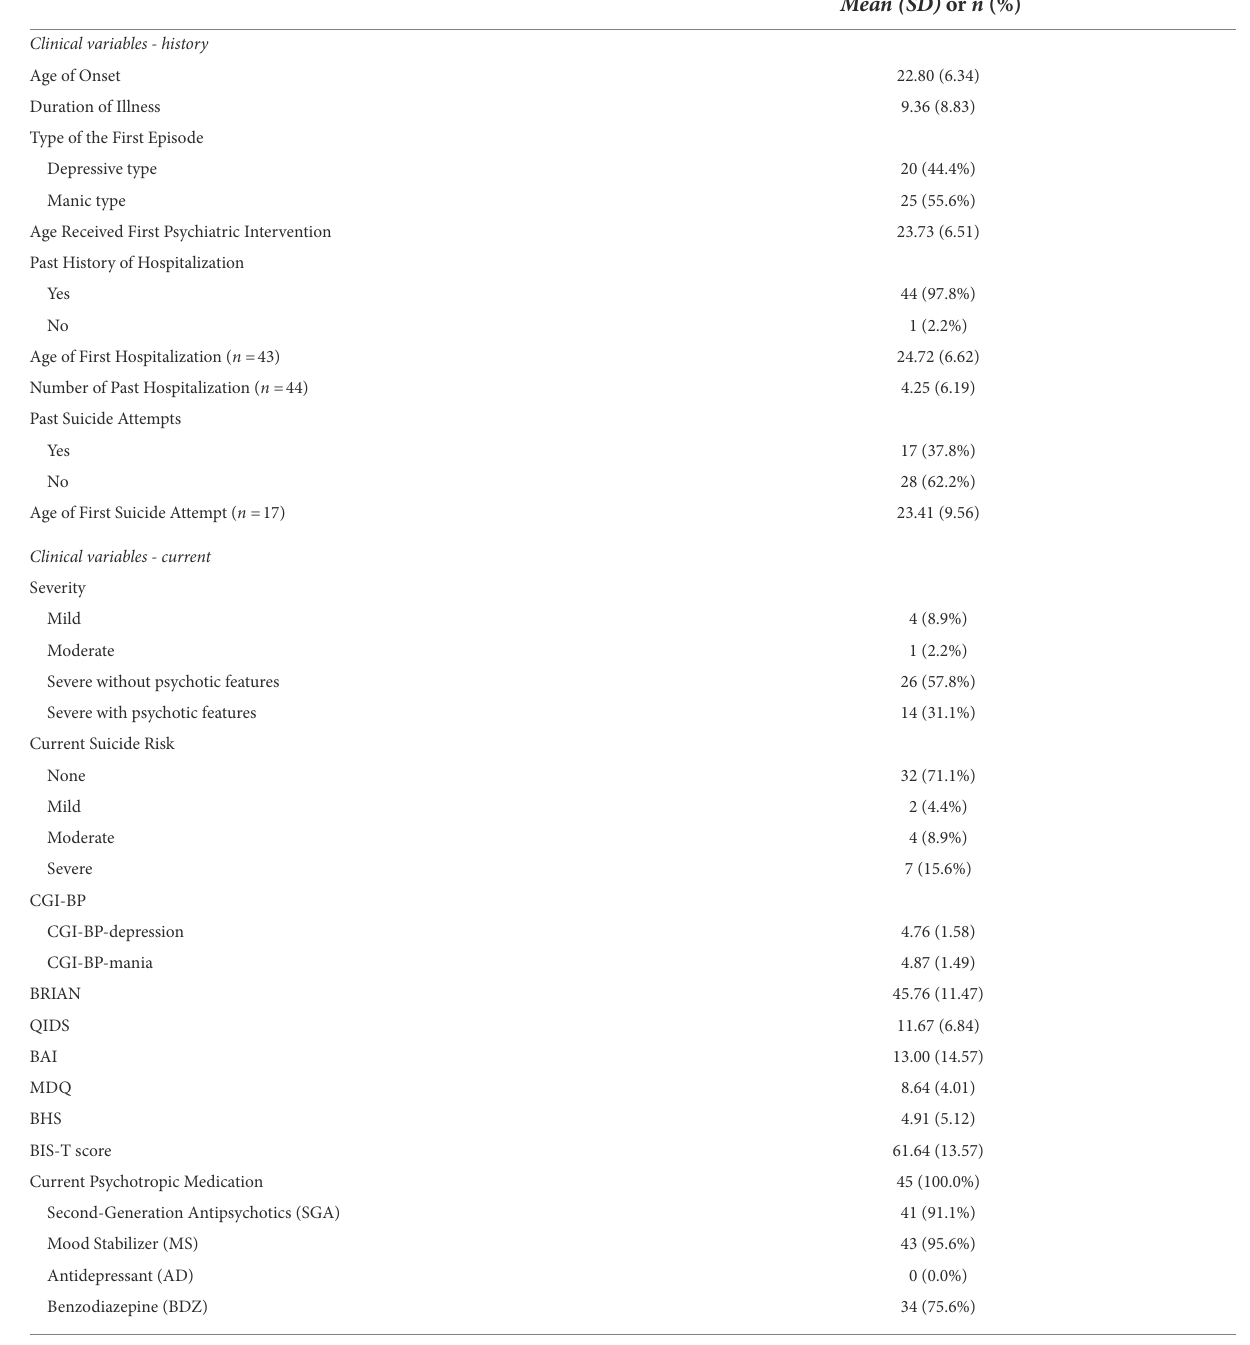
TABLE 2 Clinical characteristics of bipolar disorder (BD)